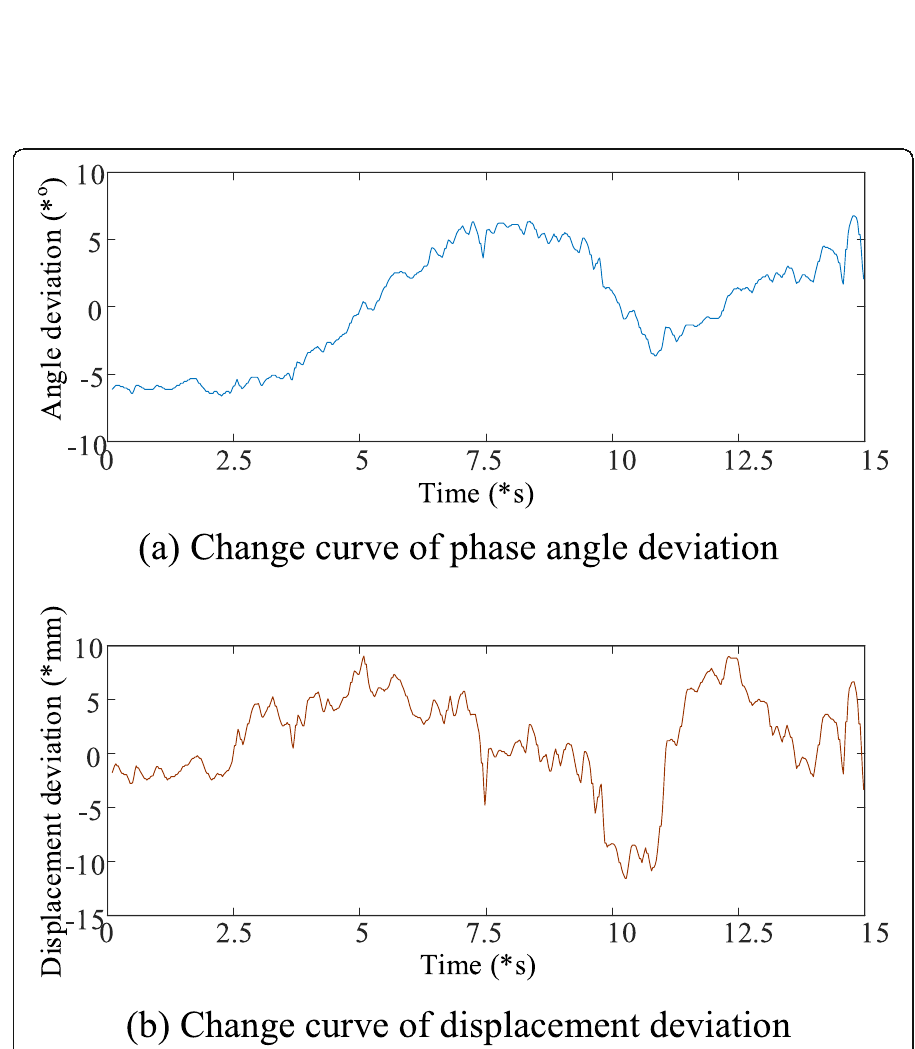
Fig. 12 Motion curve of typical scene 4. a Change curve of phase angle deviation. b Change curve of displacement